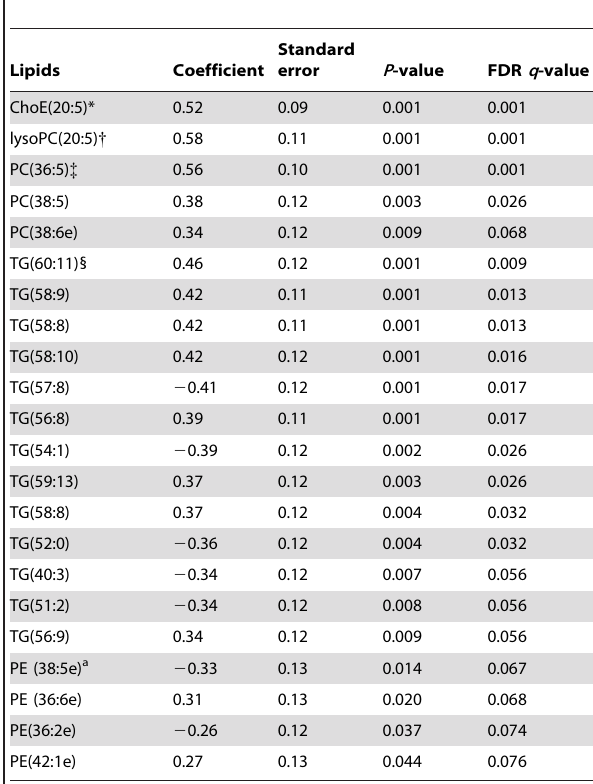
Table 5. Lipids related with plasma content of sum of EPA and DHA based on mixed model.